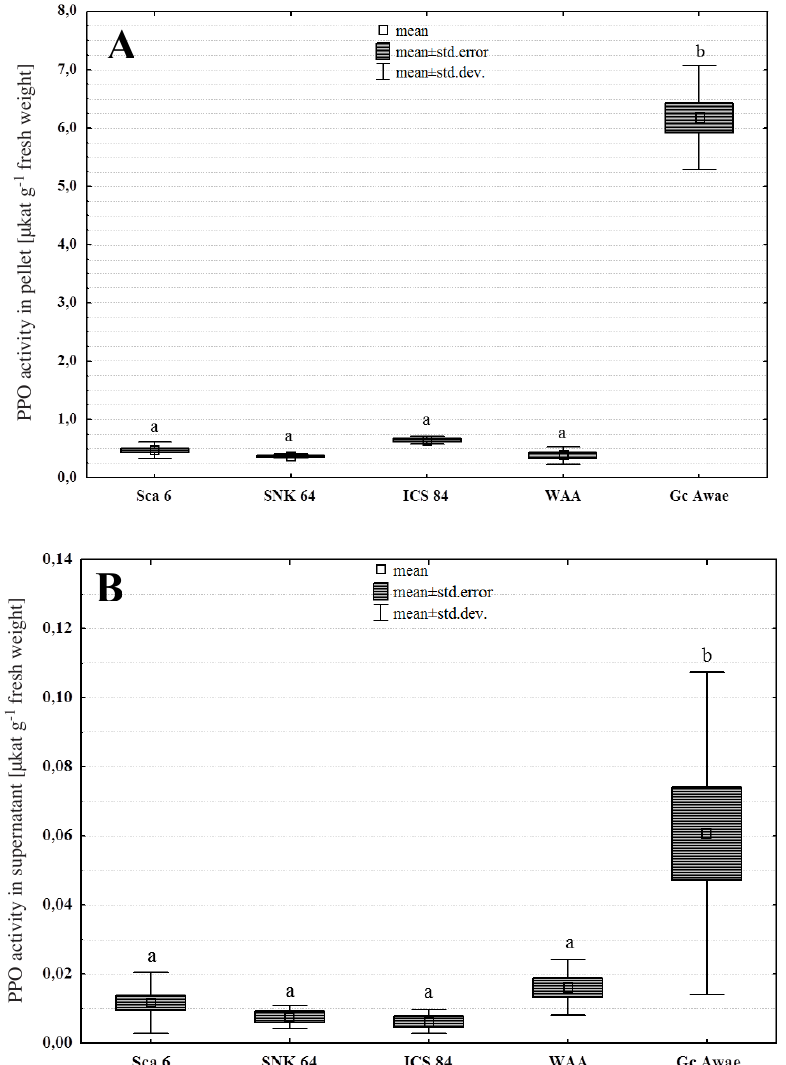
Fig. 4: Polyphenol oxidase activity in pellet (A, bound PPO) and supernatant (B, solubilized PPO) from extracted fresh seed of traditional German cacao (Gc) and hybrid varieties. Fresh seeds were extracted in Sörensen buffer and PPO estimated by using a polarographic method based on the consumption of oxygen ( m eyer et al., 1975). Mean values (n = 6) with different letters differed significantly at P < 0.05, Post hoc Test: Fisher LSD, P < 0.05. Mean is the result of two analyses from three independents cacao